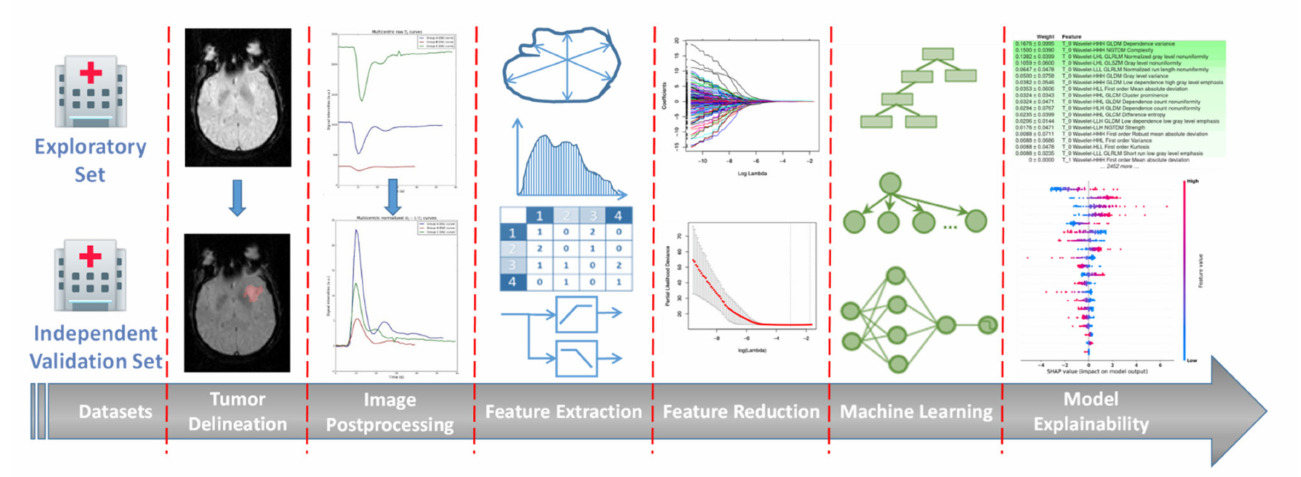
Figure 3. An illustrative representation of the proposed radiomics analysis workflow.